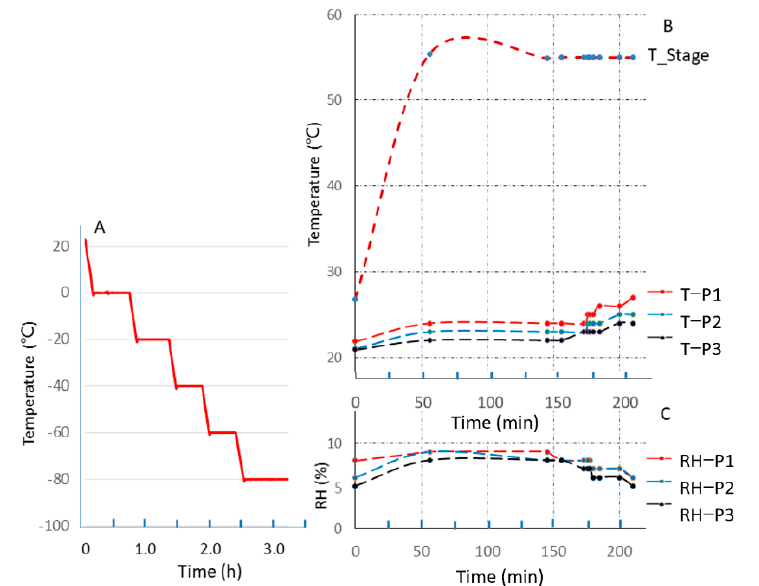
Figure 3. The heating and cooling stage (HCST) thermal and humidity cycling profile achieved in the chamber. ( A ) The temperature profile of HCST during cooling; ( B ) The temperature profiles of HCST and three-channel temperature humidity sensor above the HCST during heating; ( C ) The relative humidity profiles of the three-channel temperature humidity sensor above the HCST during heating.